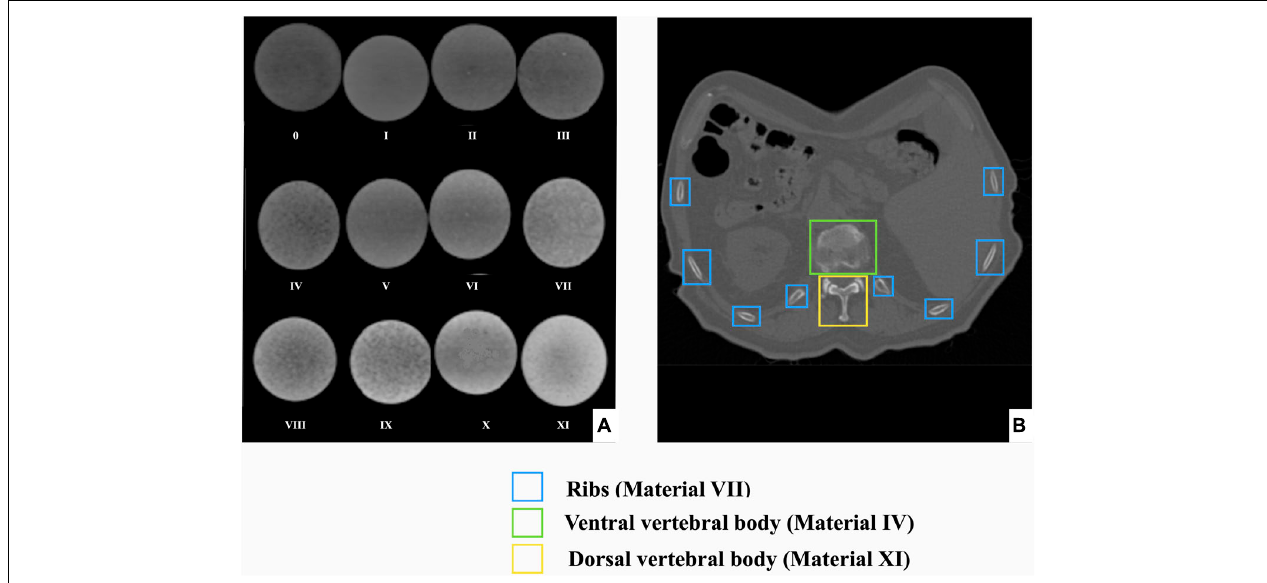
FIGURE 6 | Radiodensity analysis of radiopaque amalgamate samples and their corresponding anatomic structures in human thorax. (A) CT scan of 12 different compositions of the cured radiopaque amalgamates for radiodensity analysis, (B) Axial section of CT from a patient thorax displaying that the radiodensities of the ribs, ventral and dorsal vertebral bodies were replicated by radiopaque amalgamates VII, IV, and XI, respectively.